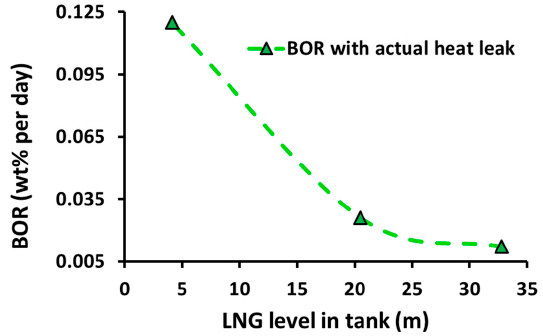
Figure 4. BOG with actual heat leakage to LNG.